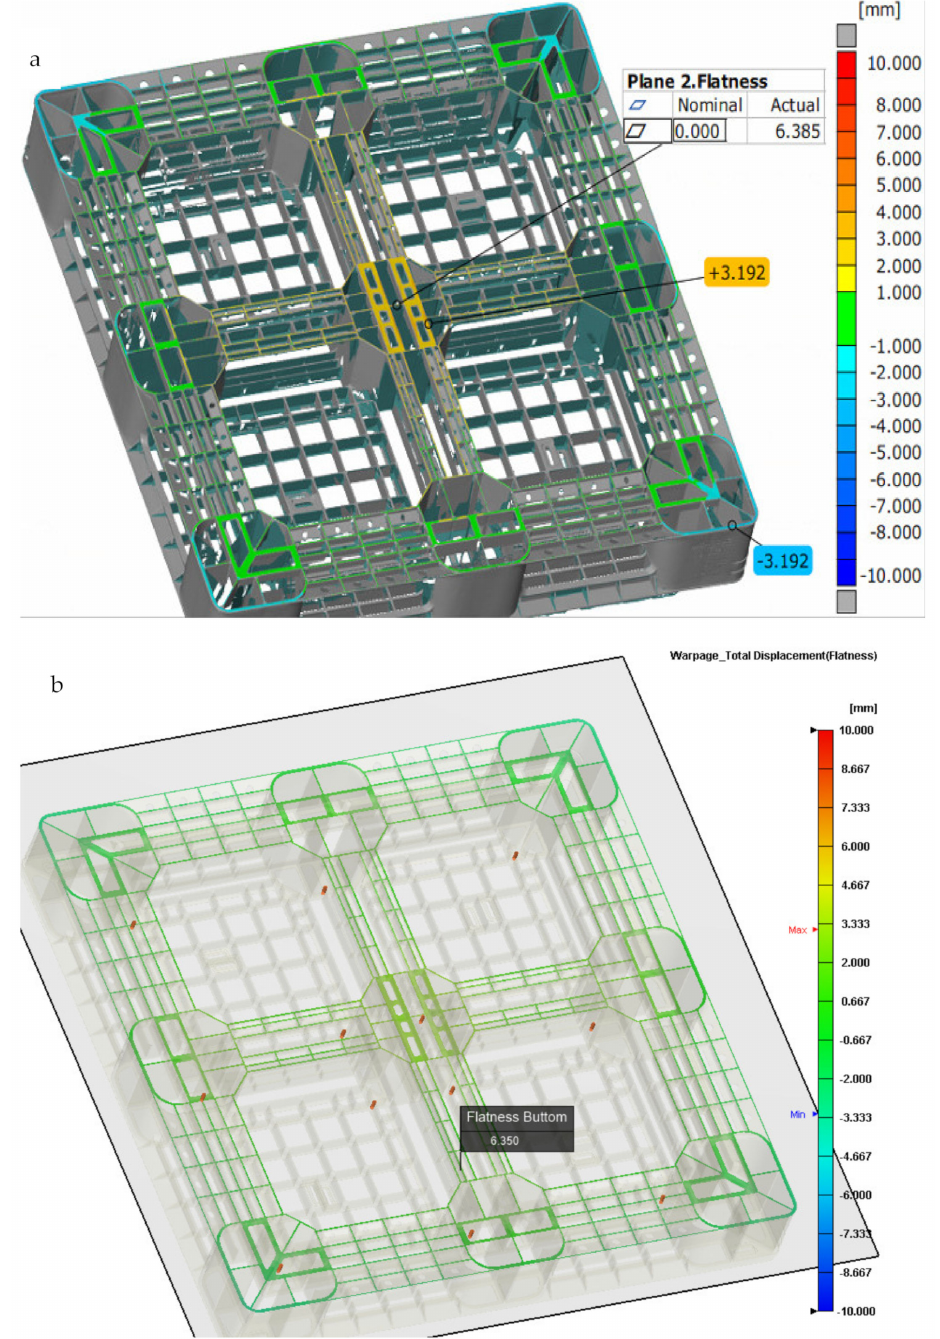
Figure 12. ( a ) The actual height profile change of the bottom side of the pallet measured by the ATOS system (flatness 6.385 mm); ( b ) simulated changes of the bottom height profile of the pallet during a packing time of 40 s by time